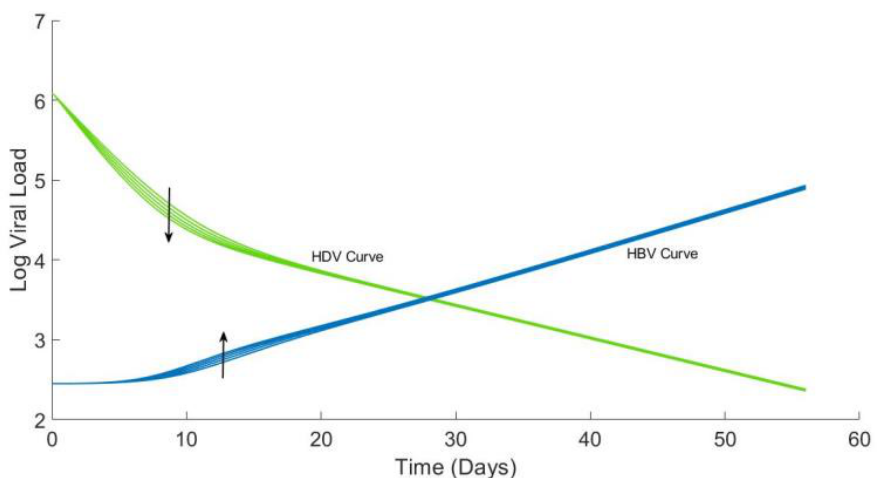
Figure A1. One-way sensitivity analysis on the impact of parameter c on predicted HBV/HDV kinetics under anti-HDV treatment. Model parameters were set to D 0 = 1,202,260, B 0 = 282, κ = 26,137, n = 1.25, g = 0.094, τ = 0.1, and ε = 0.97, with c being set at c = (0.423, 0.4465, 0.47, 0.4935, 0.517). The arrows depict the direction of increase of the parameter c.